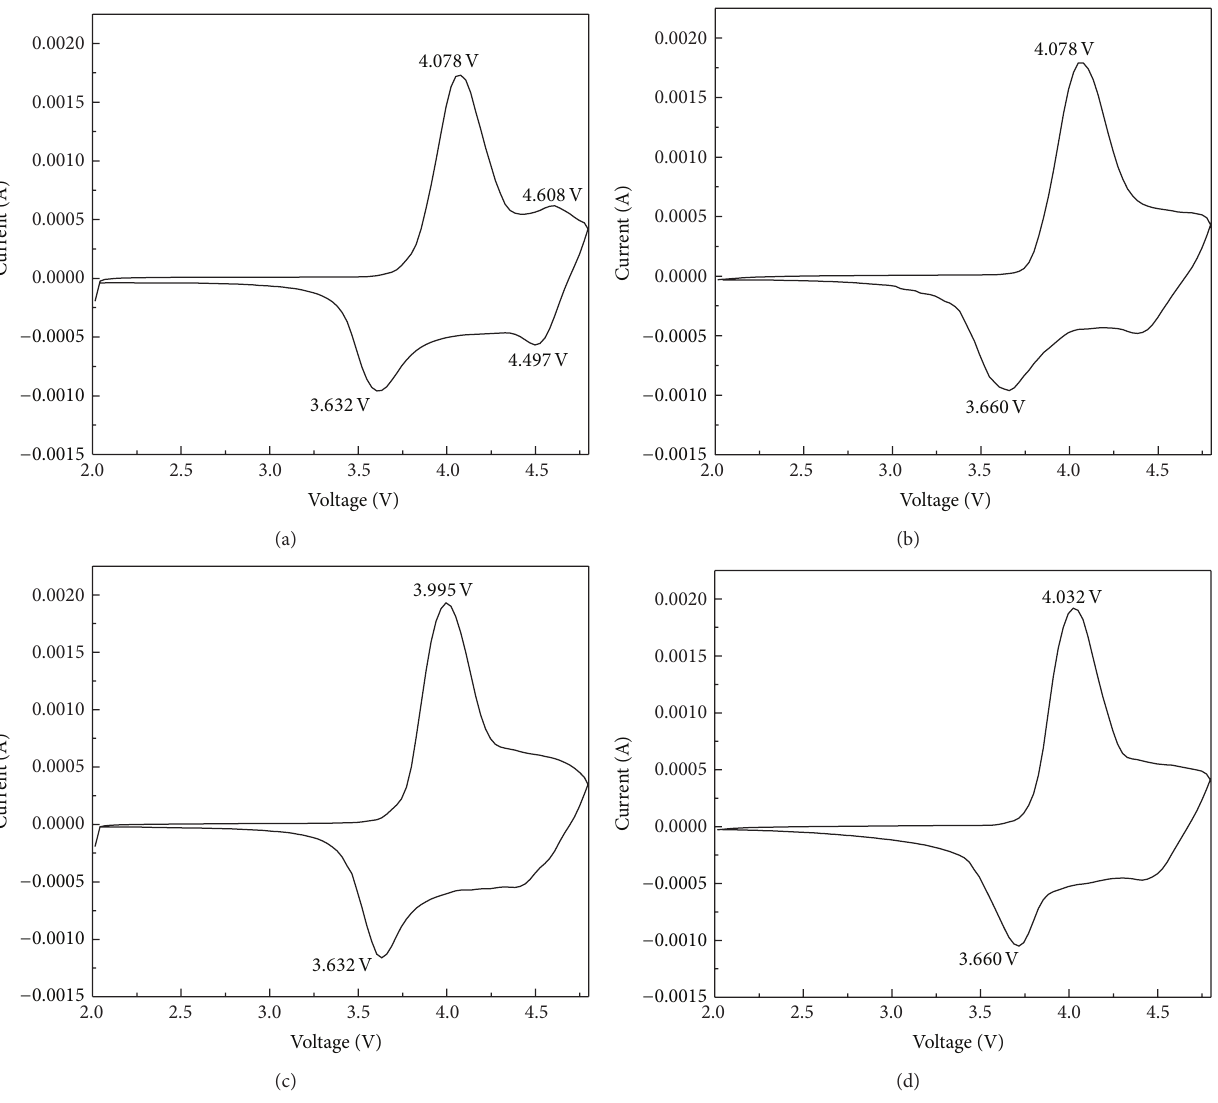
Figure 7: Cyclic voltammograms for the first curves obtained from LiNi 1/3 Co 1/3 Mn 1/3 O 2−𝑥 Cl 𝑥 for (a) 𝑥 = 0.00 ; (b) 𝑥 = 0.05 ; (c) 𝑥 = 0.10 ; (d) 𝑥 = 0.15